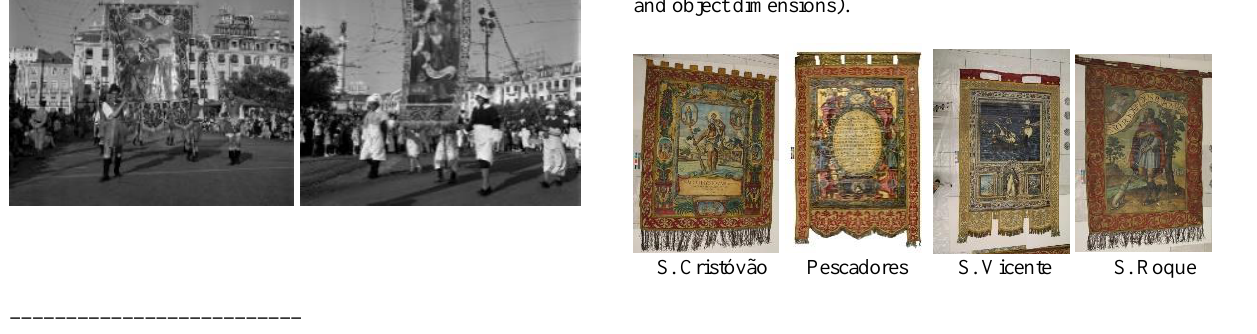
figure 2 and table 1, next page, for the relation to the banner title and object